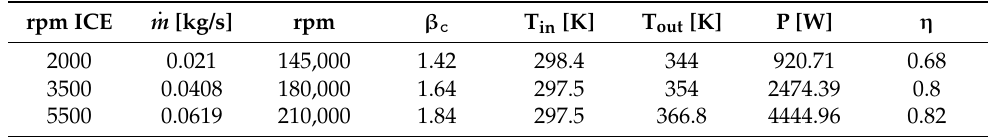
Table 2. Compressor operating points at different ICE engine rotational